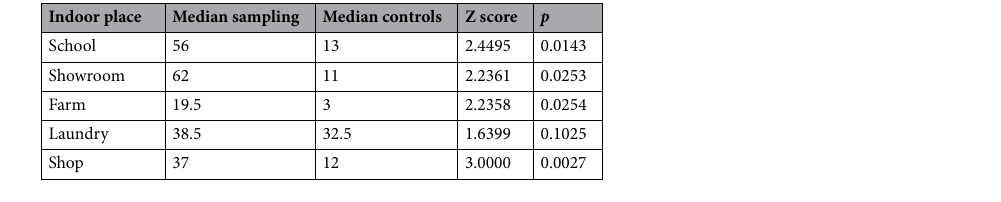
Table 1. Median test for data reported in Fig. 1